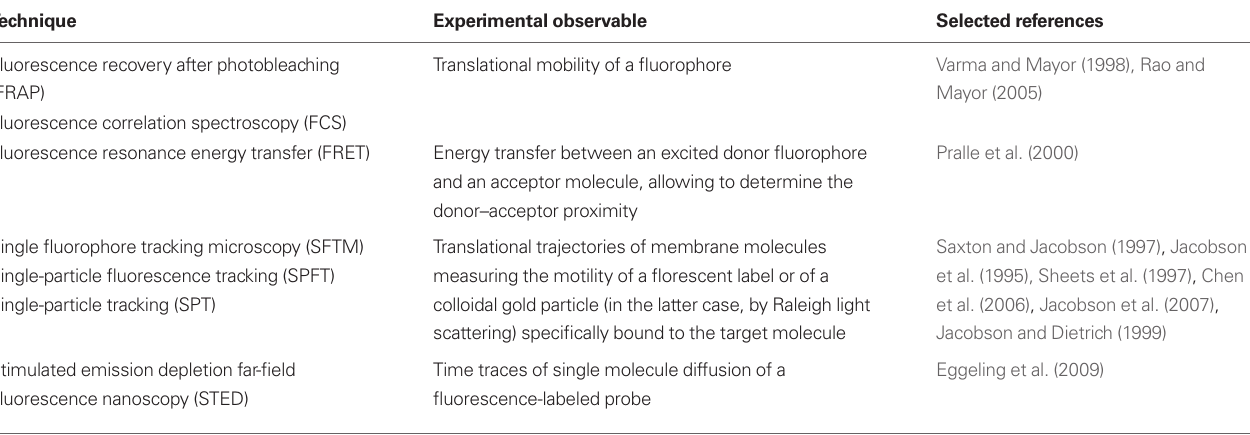
Table 1 | Some techniques used to the study of membrane heterogeneity in intact